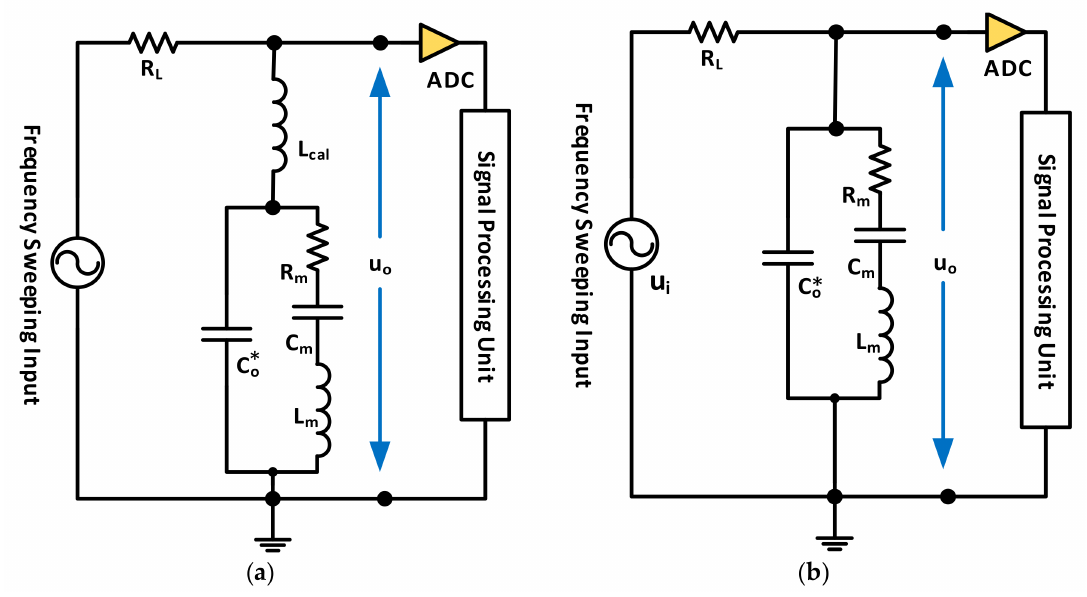
Figure 10. BVD parameters estimation system from [38] for ( a ) C o ; ( b ) R m